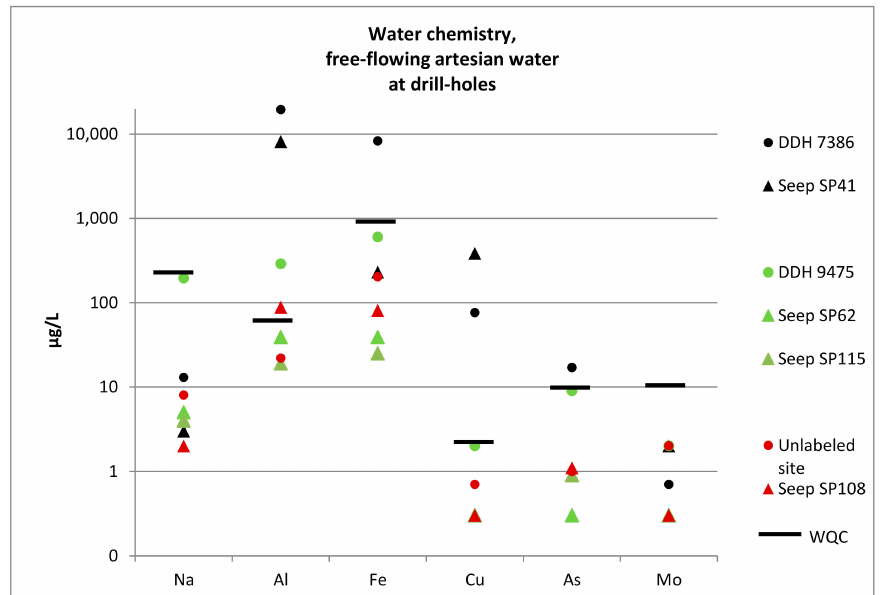
Figure 4. Artesian water chemistry. The most commonly elevated analytes from free-flowing artesian water at three drill-holes, along with maximum concentrations of analytes measured at the geographically closest groundwater seeps. Marker colors associate a drill-hole with the closest seep(s). Black bars—water quality criteria (WQC) for aquatic life [23]. For hardness-dependent metals a hardness of 25 mg / L was applied. Seep data was collected by Pebble Limited Partnership (PLP) [13].